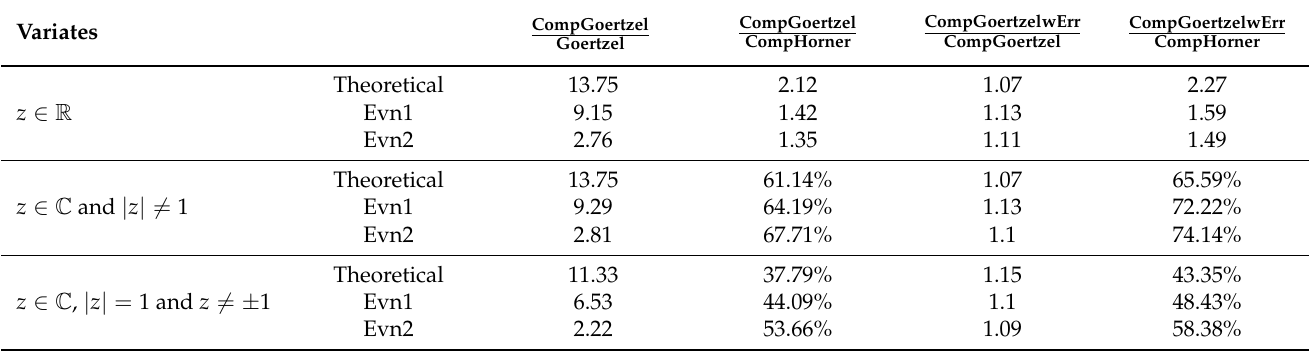
Table 3. Theoretical computational complexity and measured running time ratios in a n ∈ R .